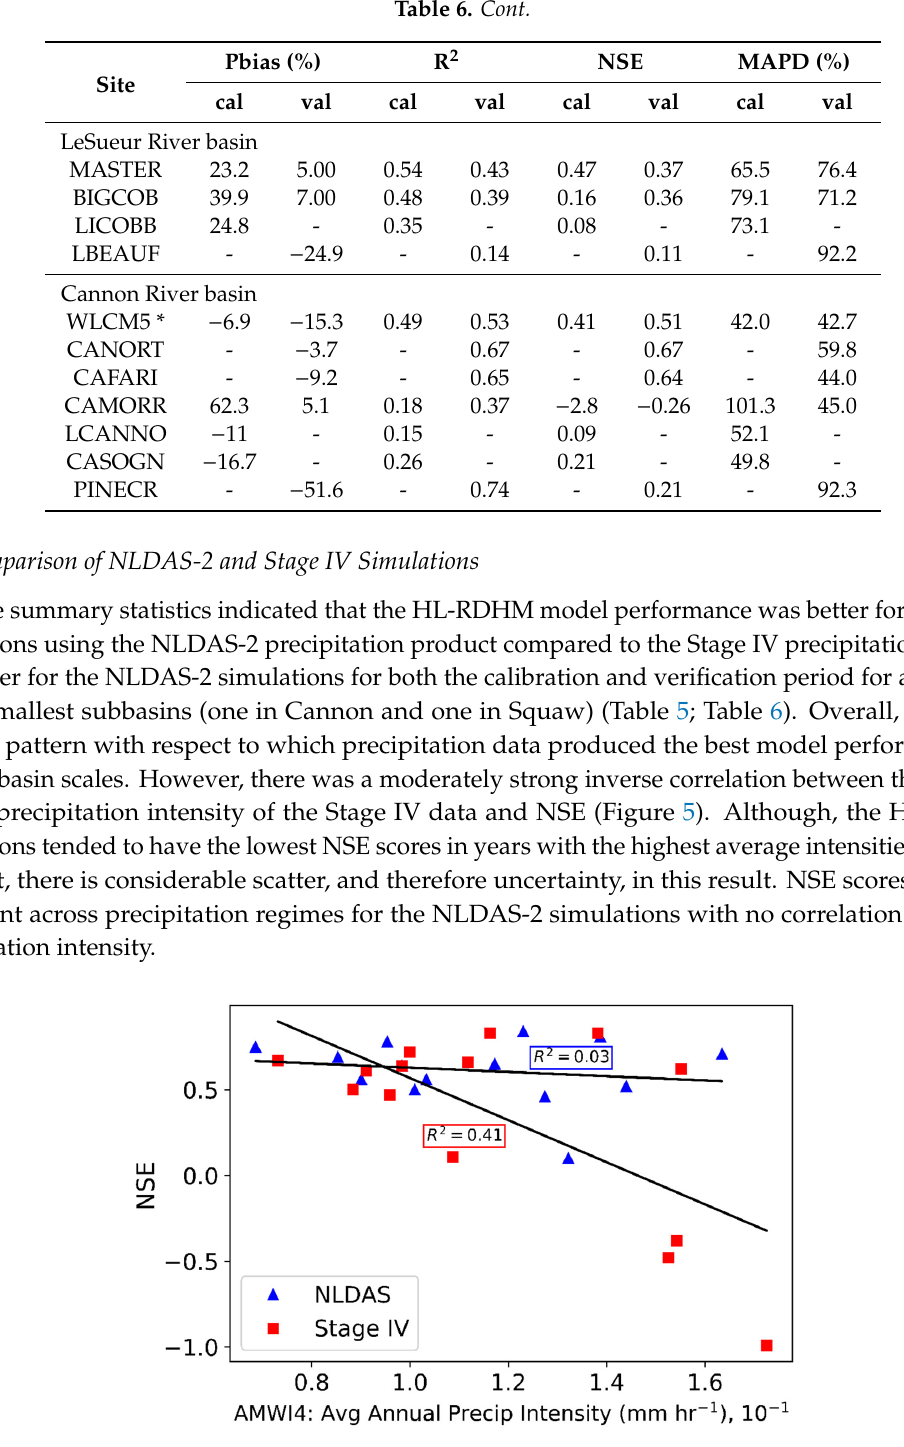
Figure 5. Average Nash-Sutcliffe efficiency (NSE) values as a function of average precipitation intensity for NLDAS and Stage IV for the period of 2003–2016. NSE; IV; R 2